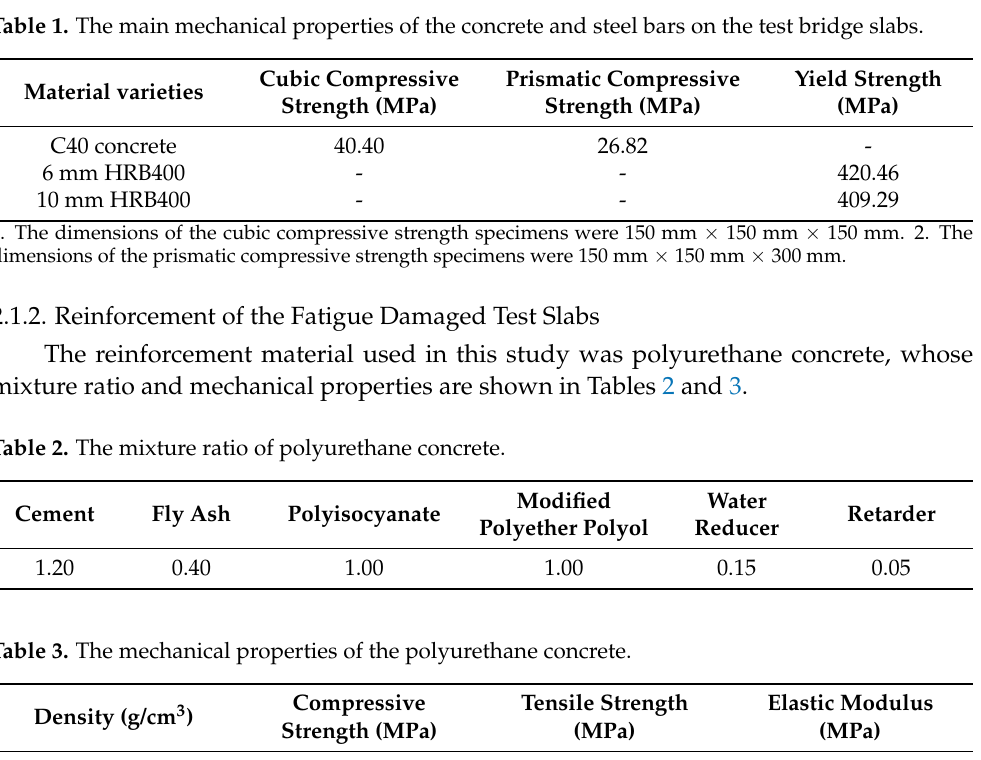
Compressive Strength (MPa)